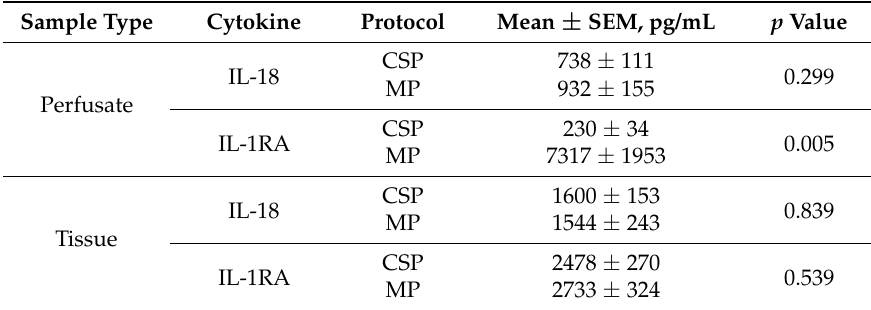
Table 3. Traditional Statistical Analyses of IL-18 and IL-1RA in MP vs. CSP